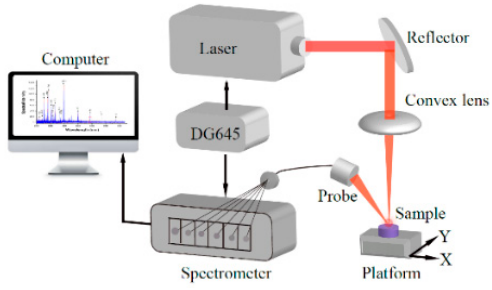
Figure 1. Schematic diagram of the LIBS experiment.